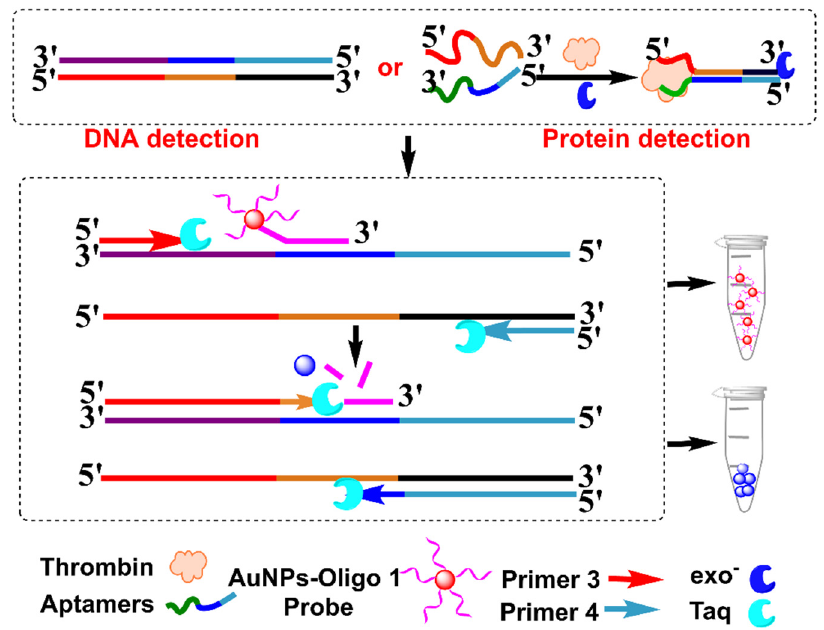
Figure 10. Schematic diagram of PCR-based sensing platform with SNAs as a TaqMan-like signal probe for colorimetric detection of Listeria monocytogenes and thrombin. Adapted with permission from ref [97]. Copyright 2019 American Chemical Society. Table 3. Comparison of specific combinations of SNAs in PCR amplification process.